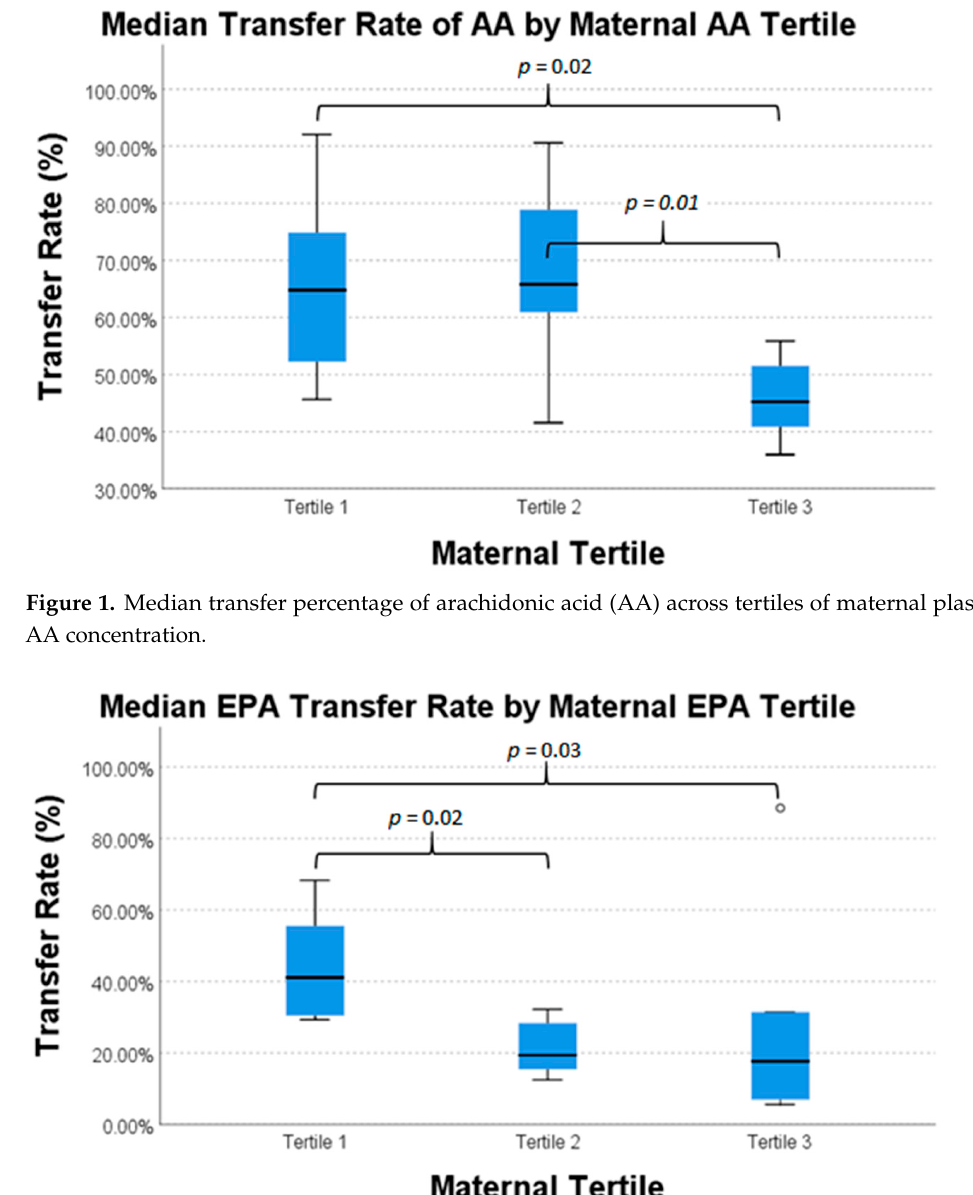
Figure 2. Intrauterine transfer percentage of eicosapentaenoic acid (EPA) across tertiles of mater ‐ nal plasma concentration.